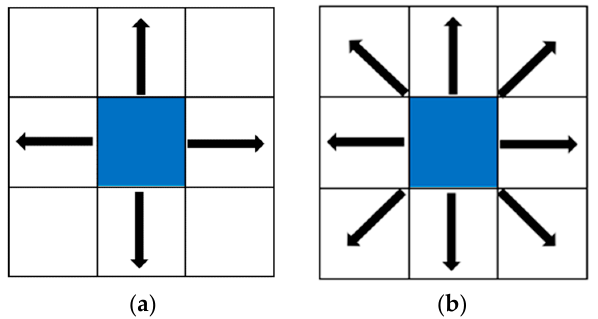
Figure 11. Symmetric path search: ( a ) four search directions of neighborhood; ( b ) eight search directions of neighborhood.